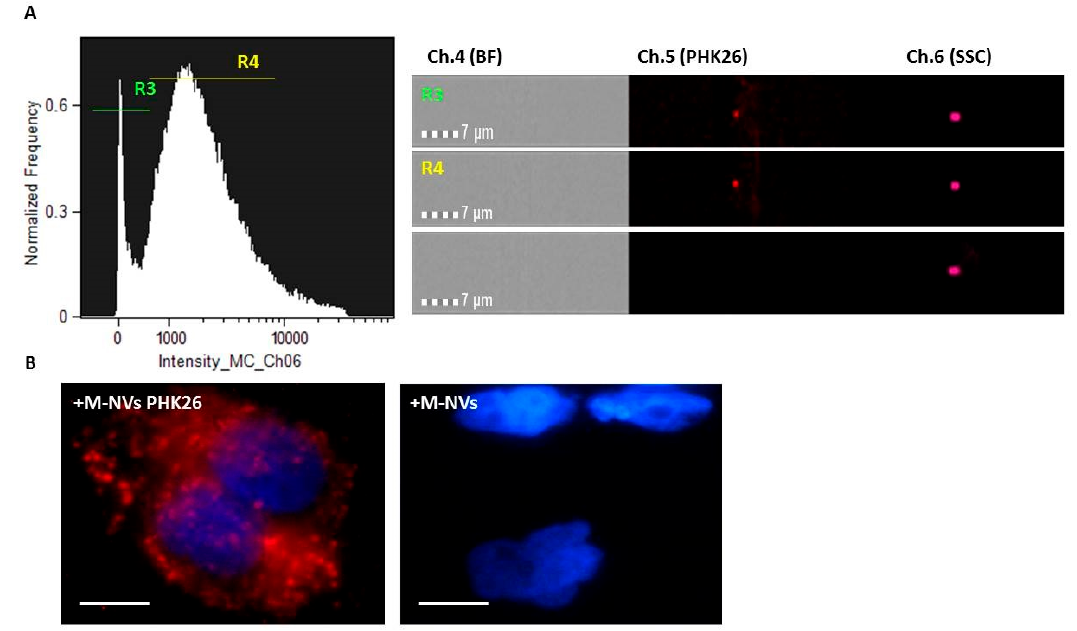
Figure 4. Amnis ImageStreamX MarkII flow cytometry and fluorescence microscope analysis of M-NVs stained with the red fluorescent PHK26 dye ( A ). PHK26 decorated M-NVs and unstained M-NVs were then separately administered to growing T98G cells. Cells were fixed after 24 h, DAPI stained and visualized under Nikon Eclipse TS100 fluorescence microscope ( B ) (100 × , scale bars = 10 µ m). For cytometry, a total of 25,000 particles were acquired.